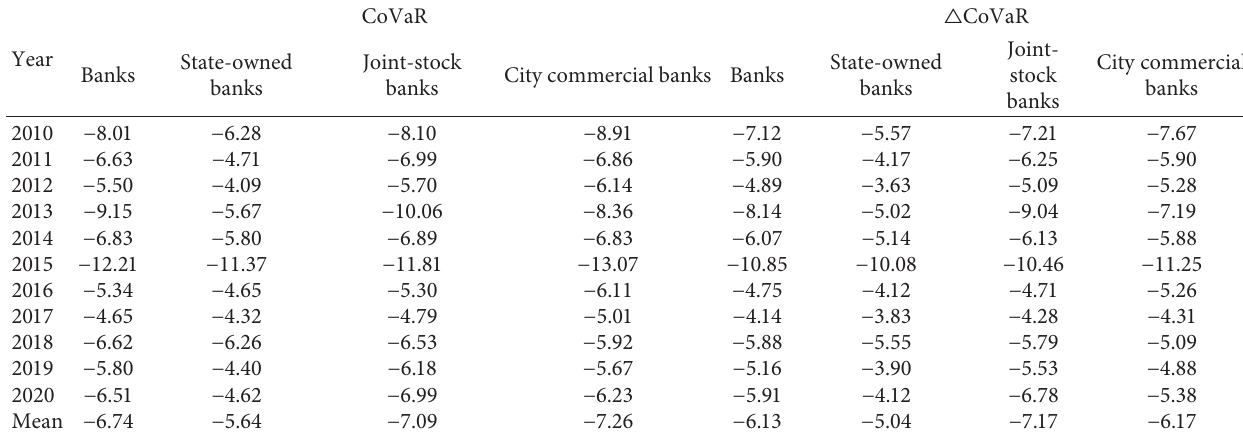
Table 4: Risk spillover effects of SMEs on various banks ( α � 5%).